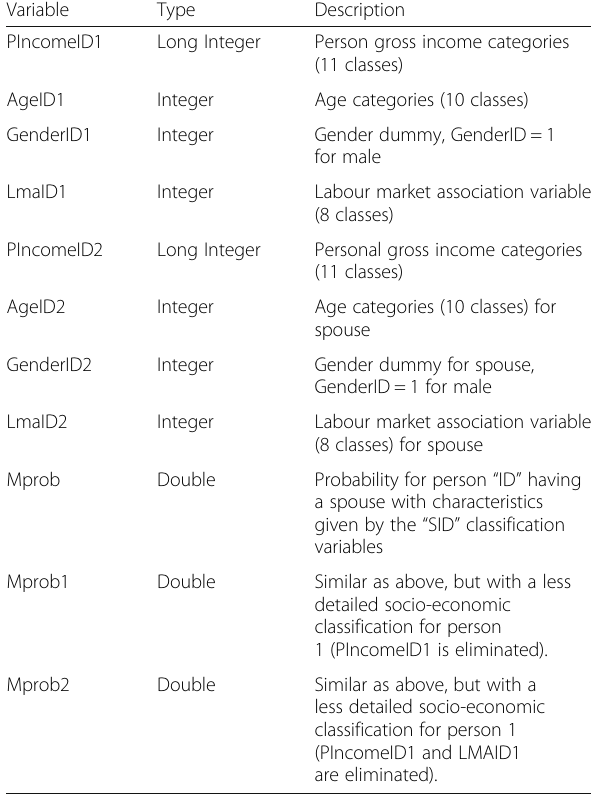
Table 9 Marginal “ Spouse matching ” probabilities for allocating individuals into households